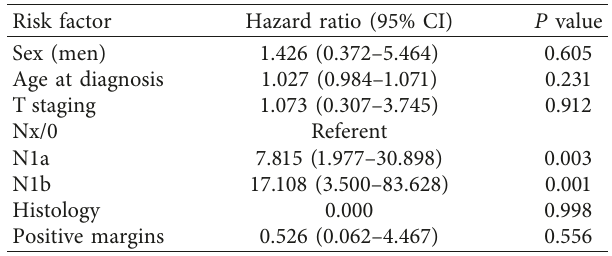
Table 5: Multivariate analysis of factors affecting disease persistence.